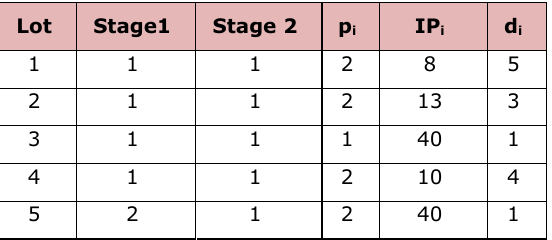
Table 8. “Data of instance number 5”. Source: Authors